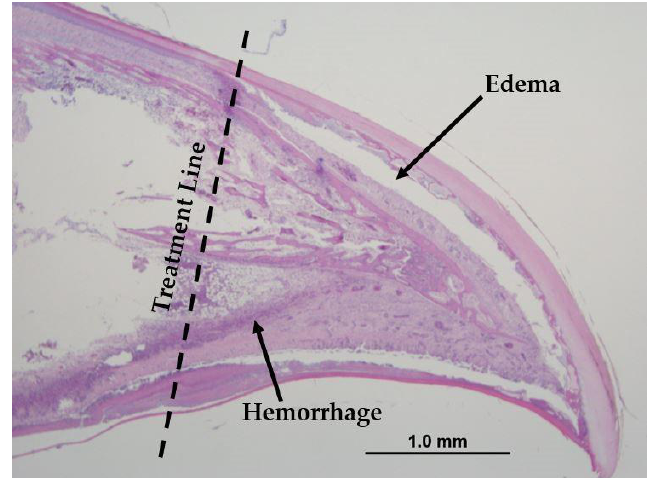
Figure 5. Histological section of the top beak of an IR pullet at 1 day post treatment (score of 4). The beak tissue below the treatment line is dead (coagulative necrosis) but still intact. Cellular infiltration, edema, and hemorrhage are present. H&E staining. Magnification 4×.